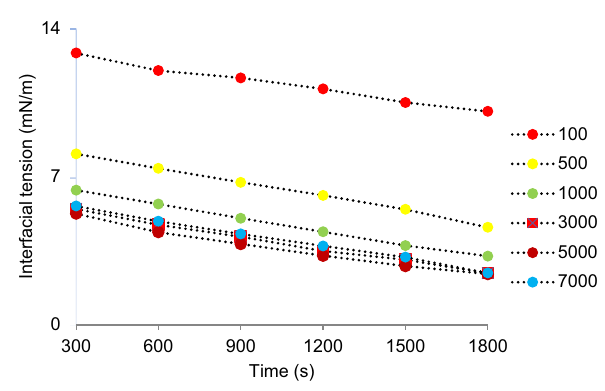
Fig. 7 Dynamic interfacial tension curves of NX-1510 solution at various concentrations with formation water base and crude oil at 351.15 K and pressure of 14.7 psi